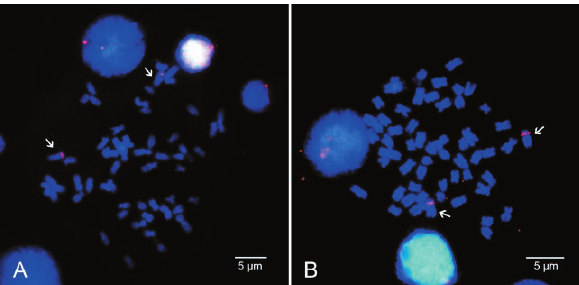
Figure 5 Metaphases of Leiarius marmoratus (A) and the hybrid “cachandiá” (B) after hybridization in situ with 5S rDNA. Arrows indicates the 5S rDNA sites